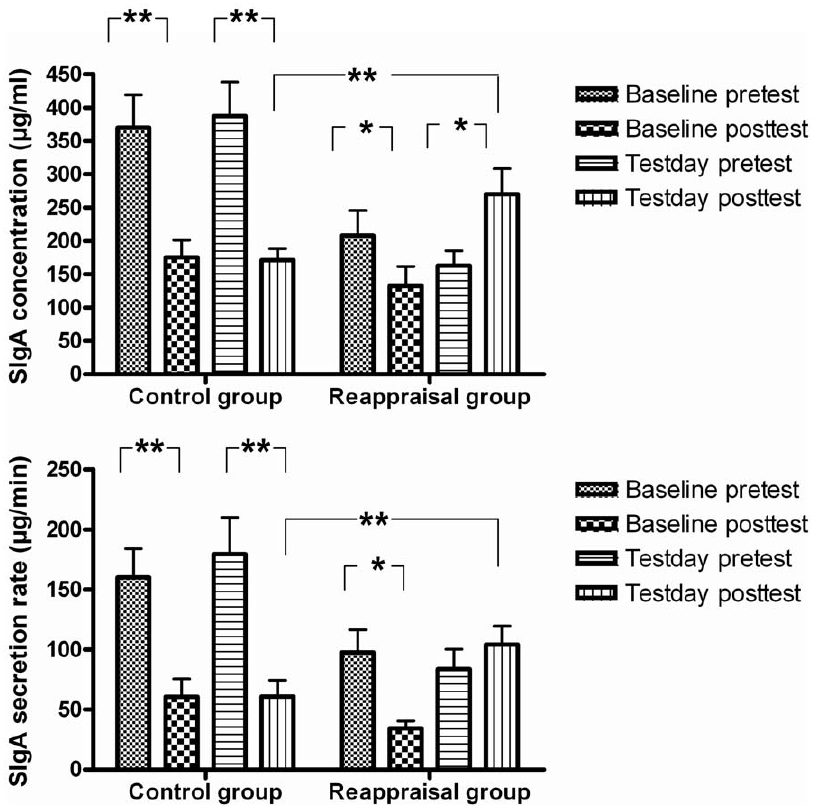
Figure 3. Changes of SIgA concentrations and SIgA secretion rates. SIgA concentrations (left) and SIgA secretion rates (right) in the pretest and posttest during the baseline and test days for the control and reappraisal group. Notably, both were significantly increased after cognitive reappraisal in the reappraisal group as compared to the control group.